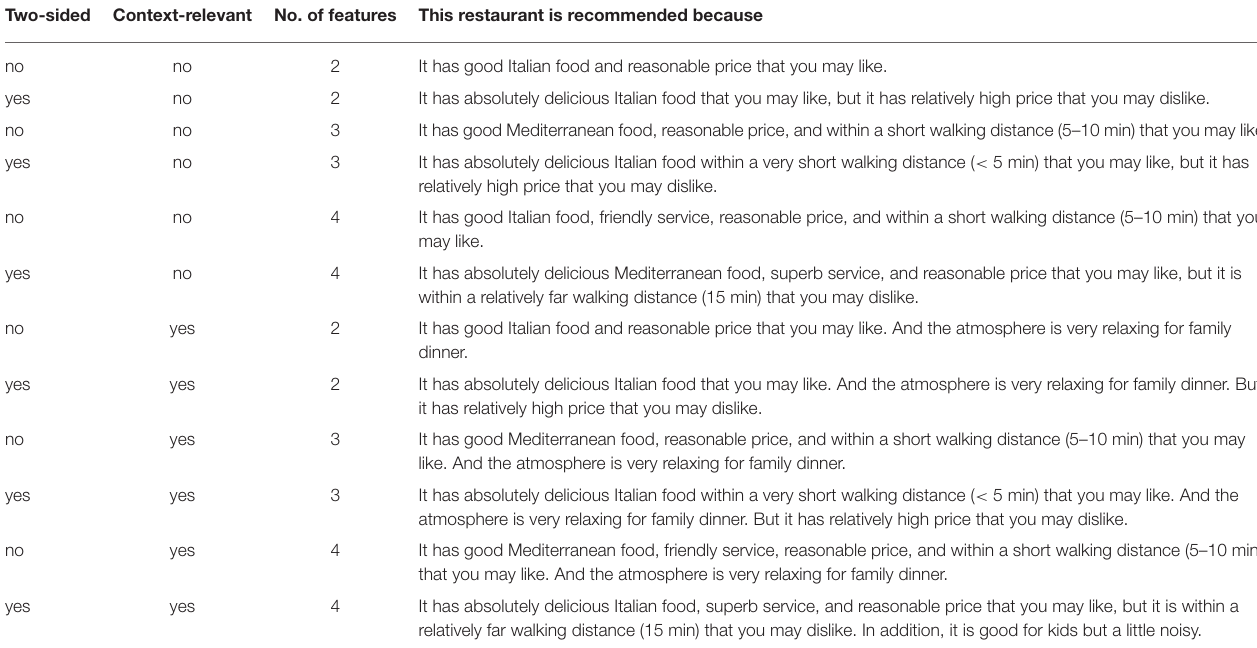
TABLE 4 | (Formal study) 12 feature-based explanations respectively associated to 12 different restaurants. Two-sided Context-relevant No. of features This restaurant is recommended because 2 It has good Italian food and reasonable price that you may